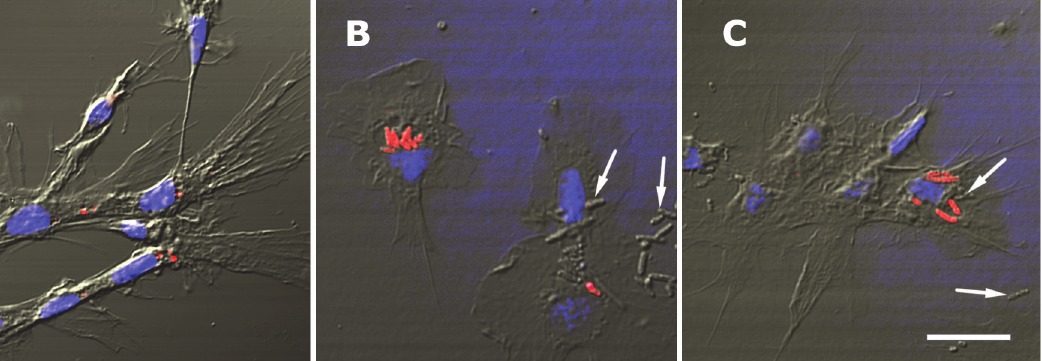
Fig 5. In vitro phagocytosis of E . coli cells by circulating hemocytes (LysoTracker Red-Hoechst 33258). (A) A group of control hyalinocytes, some of them showing small acidic granules. (B) Hemocytes exposed to E . coli ; a phagocyte (upper left) showing a group of internalized red-labeled bacteria, while another phagocyte (lower right) shows a single internalized bacterium. Small acidic granules are not seen in these hemocytes, whether phagocytic or not. Bacteria which are free over and around hemocytes are not labeled (arrows). (C) A group of hemocytes, one of them showing several internalized bacteria in different degrees of digestion. Small acidic granules are not seen in these hyalinocytes. Non internalized bacteria are not labeled by LysoTracker Red (arrows). Scale bar represents 10 μ